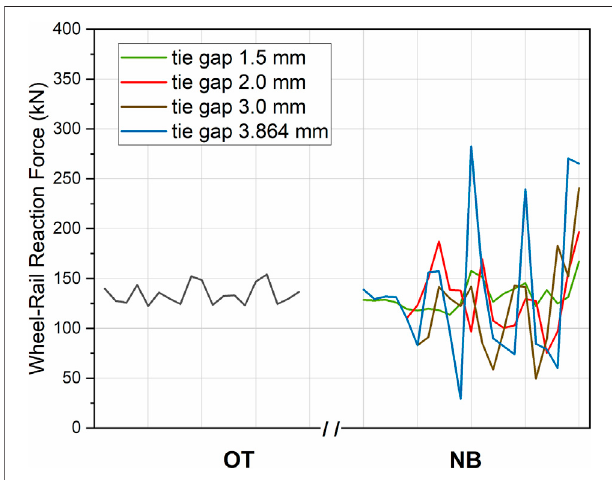
FIGURE 14 | Reaction force between wheel and rail of wheel 1 with passenger train passage at the NBL when tie gap was varied between 1.5, 2, 3, and 3.864